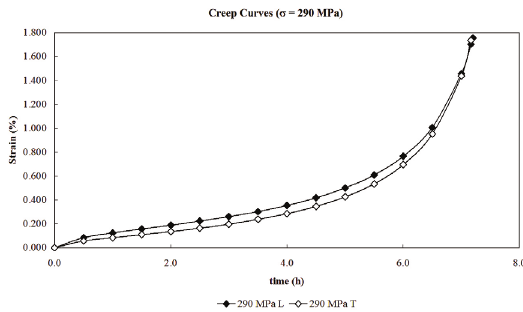
Figure 17. Creep curves at 290 MPa for AA7050-TAF (all three stages